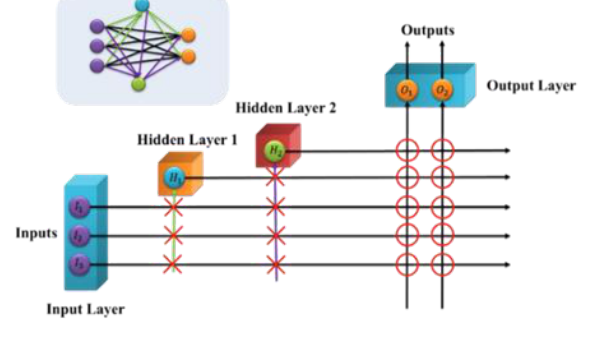
Figure 6. The scheme of the CCN